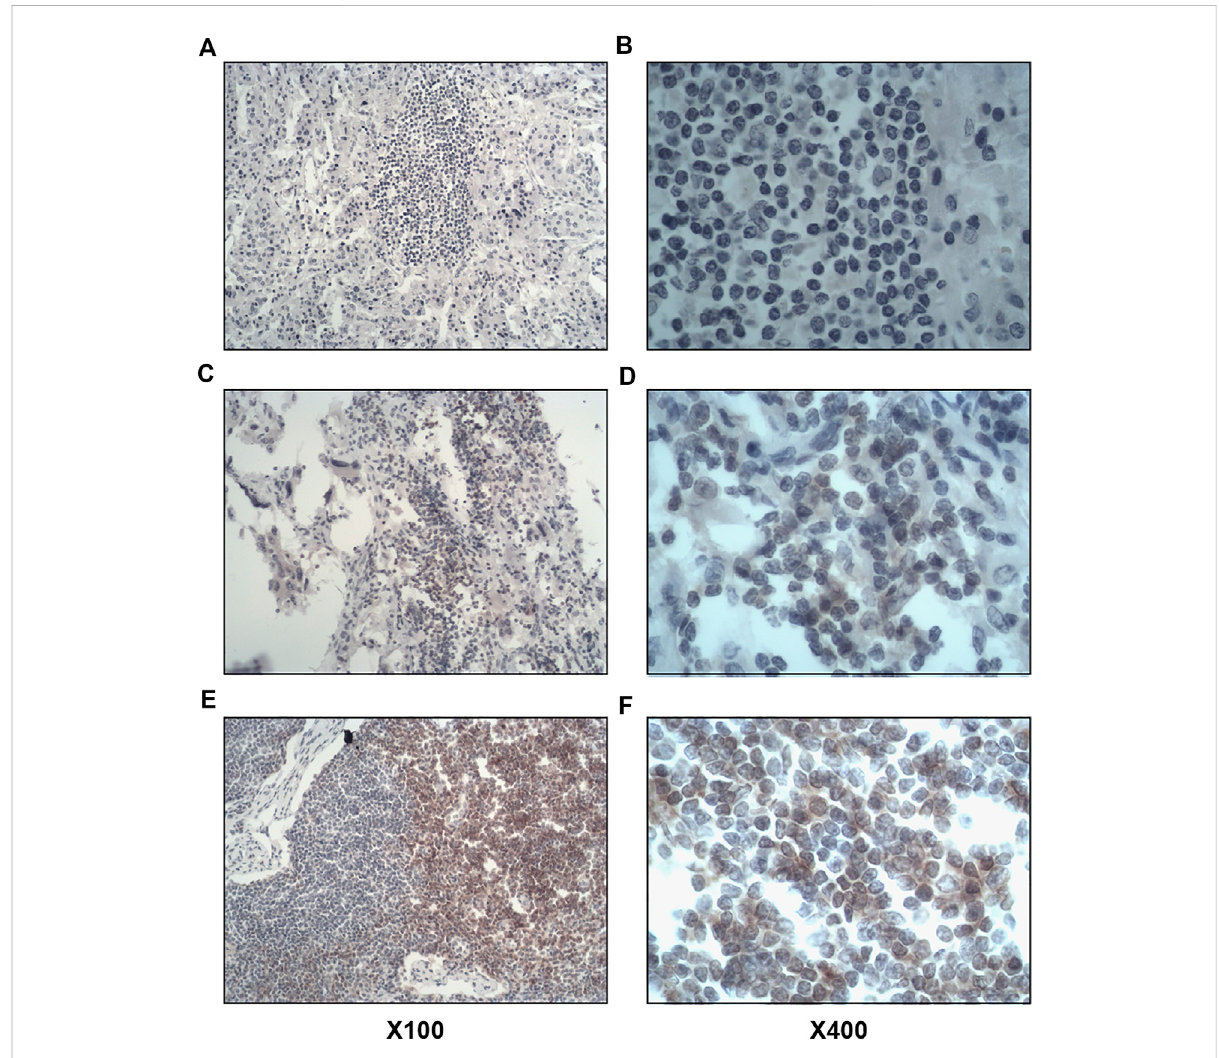
FIGURE 2 Immunohistochemical staining of CD4 + lymphocyte in fi ltration in tumor tissues. Left image × 100, right image × 400. (A,B) , Negative for intratumoral and stromal CD4 + lymphocyte in fi ltration. (C,D) , Positive for intratumoral CD4 + lymphocyte in fi ltration. (E,F) , positive for stromal CD4 + lymphocyte in fi